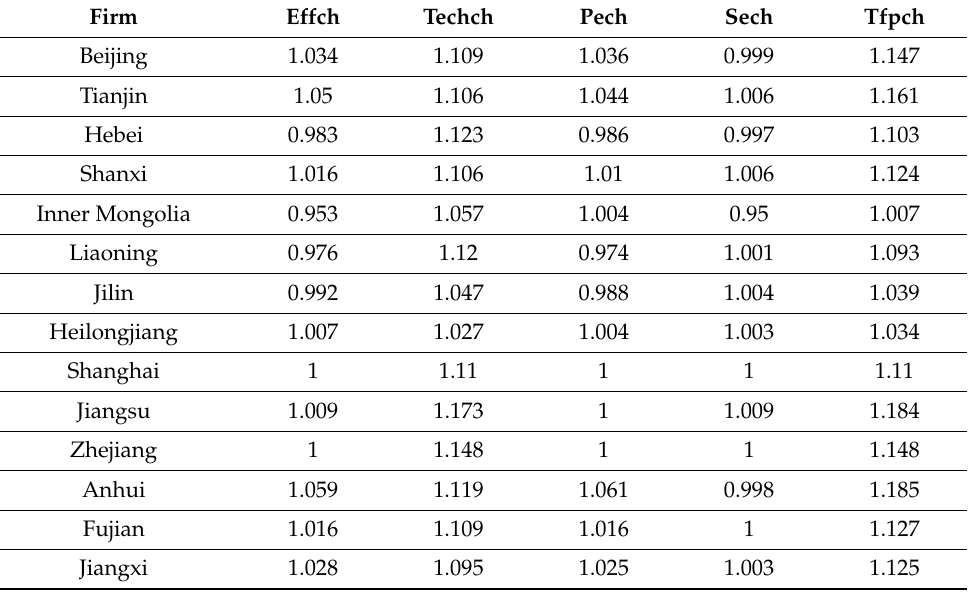
Table 2. Estimated results of forestry total factor productivity in the three stages of 2018 (after adjustment). Firm Effch Techch